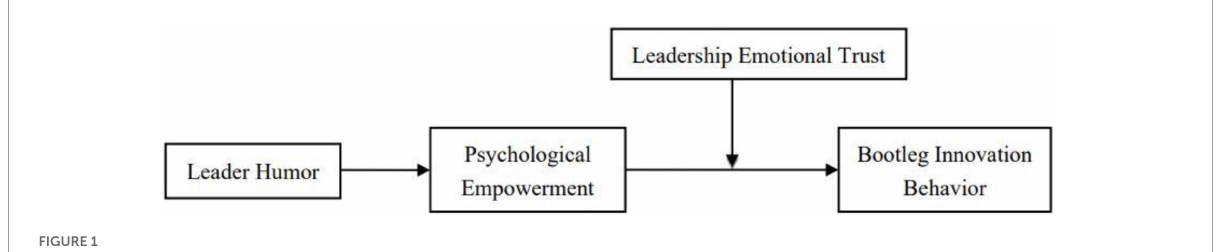
FIGURE1 Research theoretical